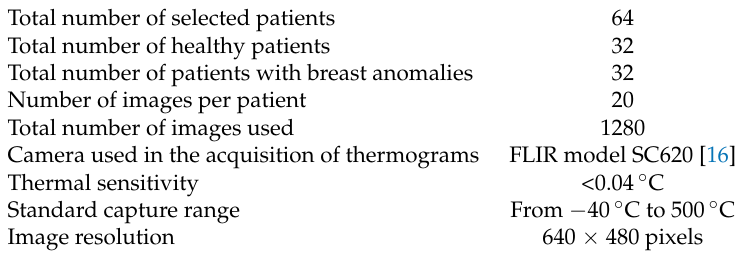
Table 1. Summary of data and camera characteristics used.